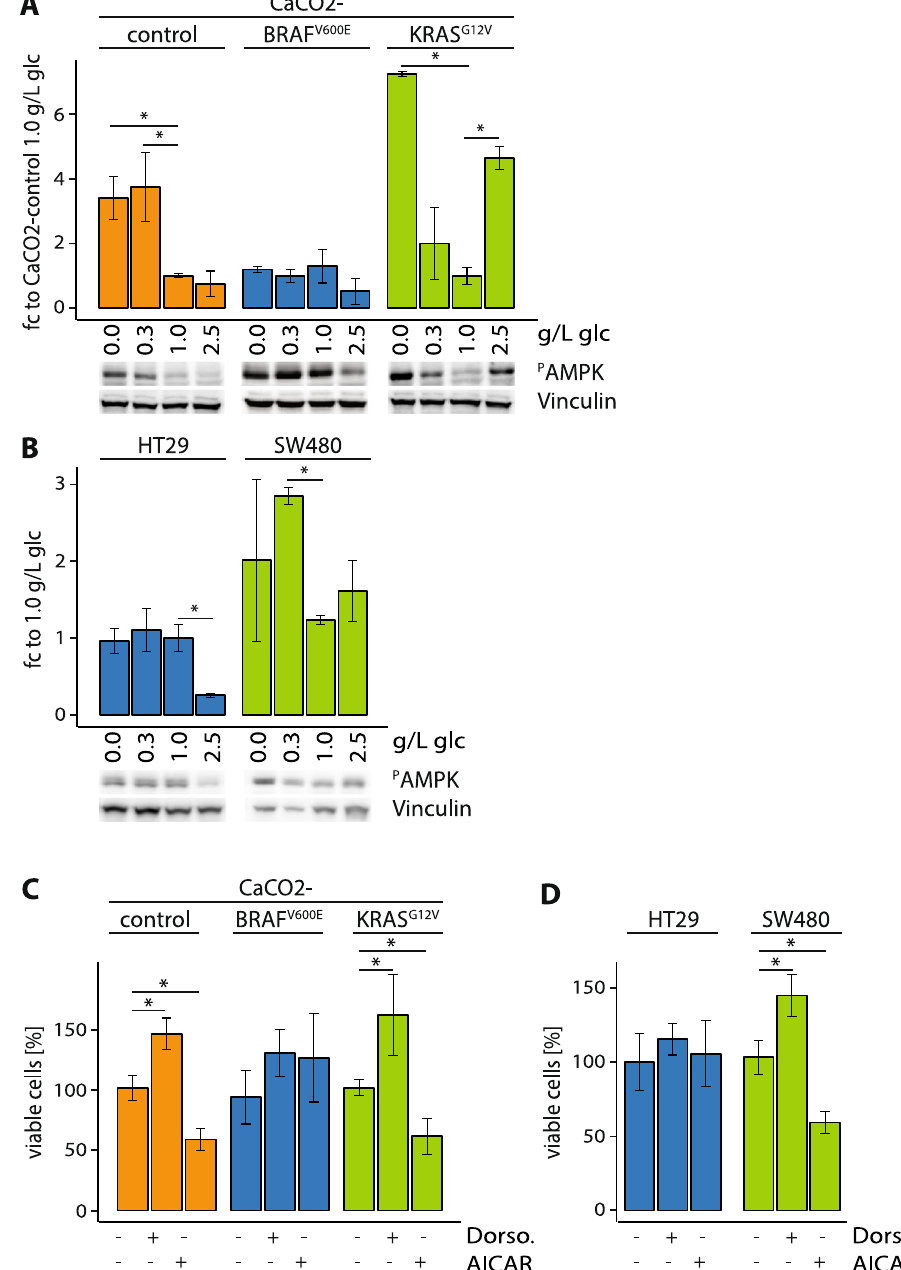
Figure 3. Decoupled AMPK signaling to mTOR in cells expressing BRAF V600E . ( A , B) CaCO2-control, CaCO2- BRAF V600E , CaCO2-KRAS G12V , HT29 and SW480 cells cultivated with indicated glucose concentrations were analyzed with antibodies against phospho-AMPK (Thr172). Vinculin served as loading control. Shown are fold changes (fc) to 1.0 g/L glucose (previously normalized to Vinculin). For each cell line samples from different glucose concentrations were loaded together on one gel. Representative images are shown. Band intensities were measured using Image J. Western blot results were combined from (in minimum) n = 3 independent experiments. p < 0.05 was indicated with asterisk (unpaired two-tailed t Test). Full-length blots are shown in the Supplementary Information. ( C , D) CaCO2-control, CaCO2-BRAF V600E , CaCO2-KRAS G12V , HT29 and SW480 cells grown with 1.0 g/L glucose were treated with 1 µ M AMPK inhibitor Dorsomorphin (Dorso., + ), 1 mM AMPK activator AICAR ( + ) or DMSO ( − ) for 24 h. Shown are viable cells compared to DMSO. glc: glucose. Shown are standard deviation of (in minimum) n = 3 replicates. p < 0.05 was indicated with asterisk (unpaired two-tailed t